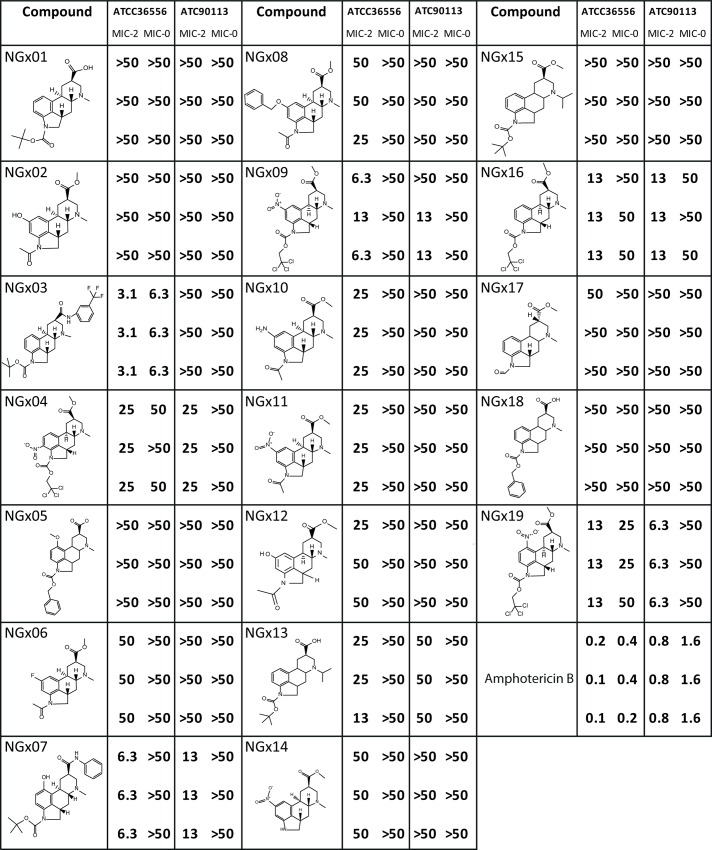
Antifungal testing.C. neoformans growth inhibition by NGx04 scaffolds. NGx04 and close analogues were tested against C. neoformans ATCC 36556 and ATCC 90113 in a 72 h proliferation assay and MIC-2 (50% inhibition) and MIC-0 (no visible fungal growth) determined. Triplicate values are given in μg/ml. Amphotericin B was included as positive control.